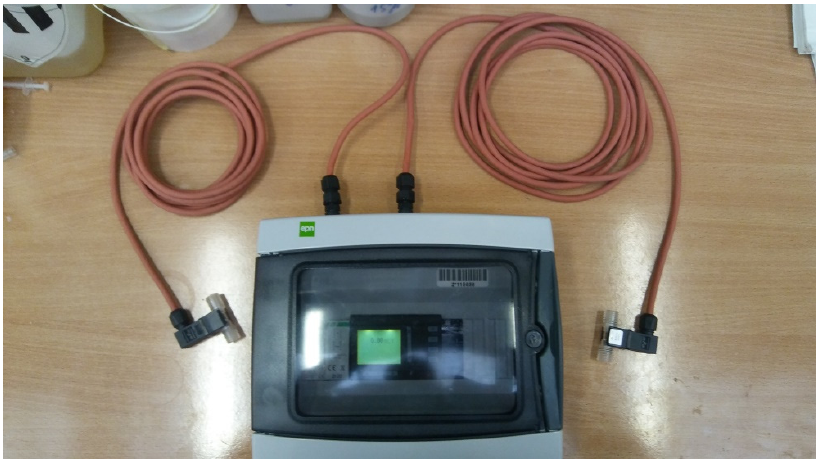
Figure 6. The PLC controller with flow meters.